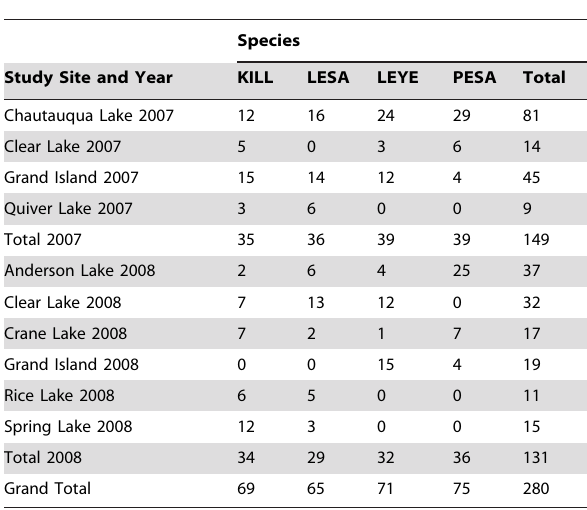
Table 1. Number of Killdeer (KILL), Least Sandpipers (LESA), Lesser Yellowlegs (LEYE), and Pectoral Sandpipers (PESA) collected and included in analyses of size-corrected body mass by site, year, and